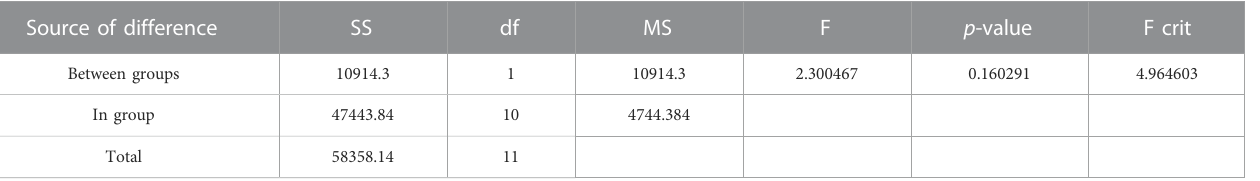
TABLE 11 Variance analysis of ultrasonic power on point A.